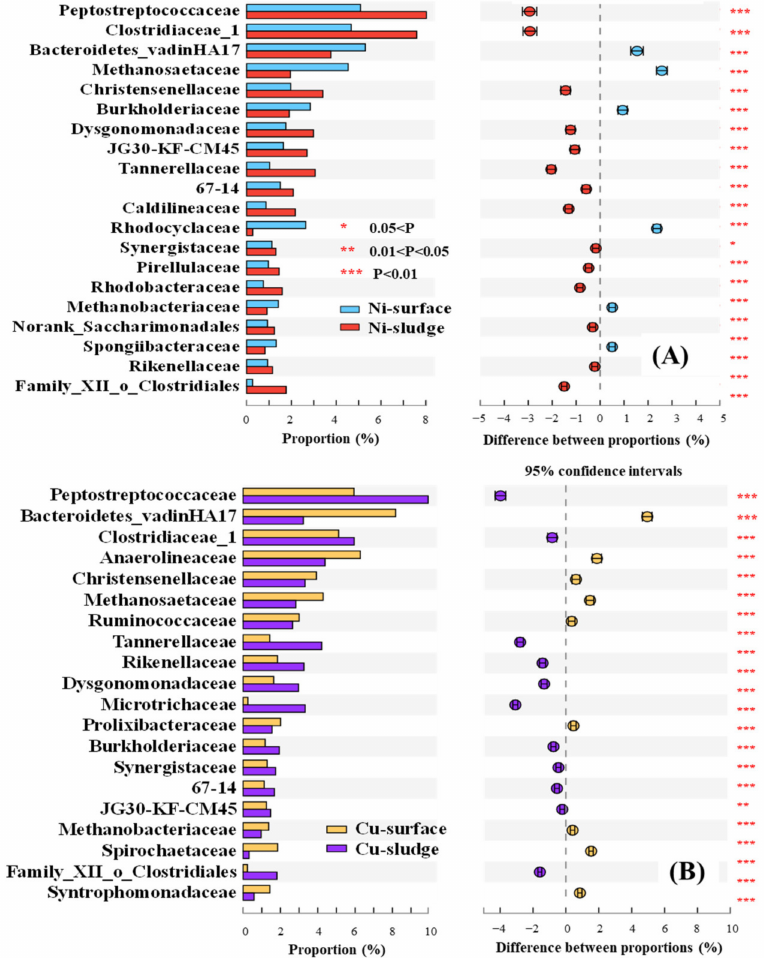
Figure 7. Community differences between ( A ) Ni surface or ( B ) Cu surface and corresponding